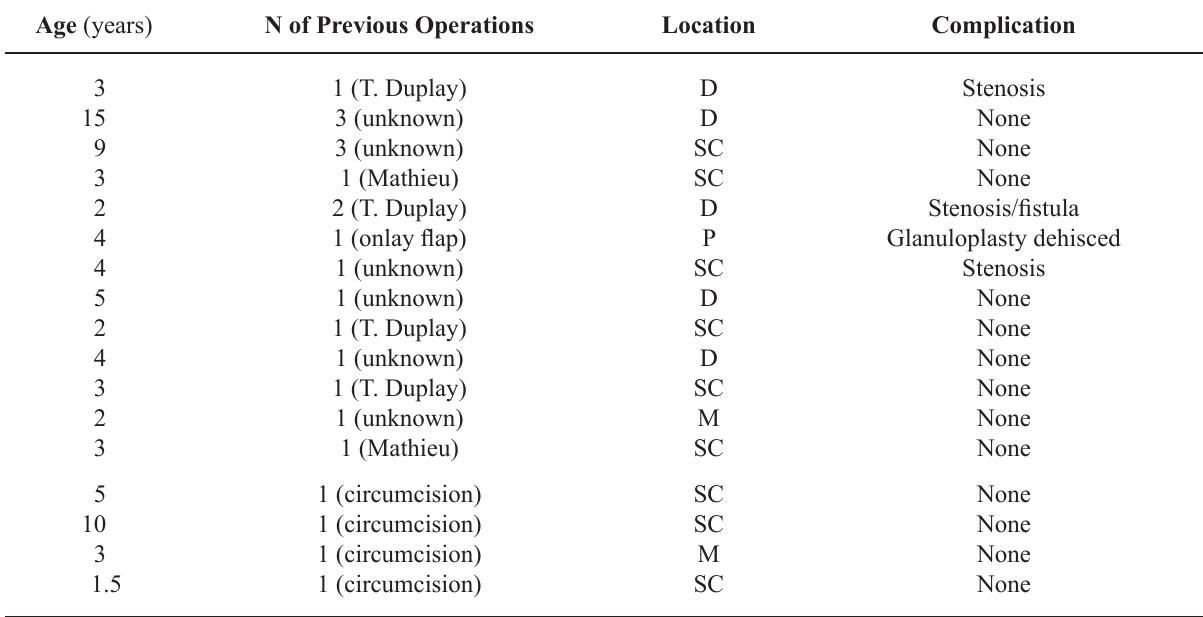
Table 1 – Summary of patients’ characteristics and